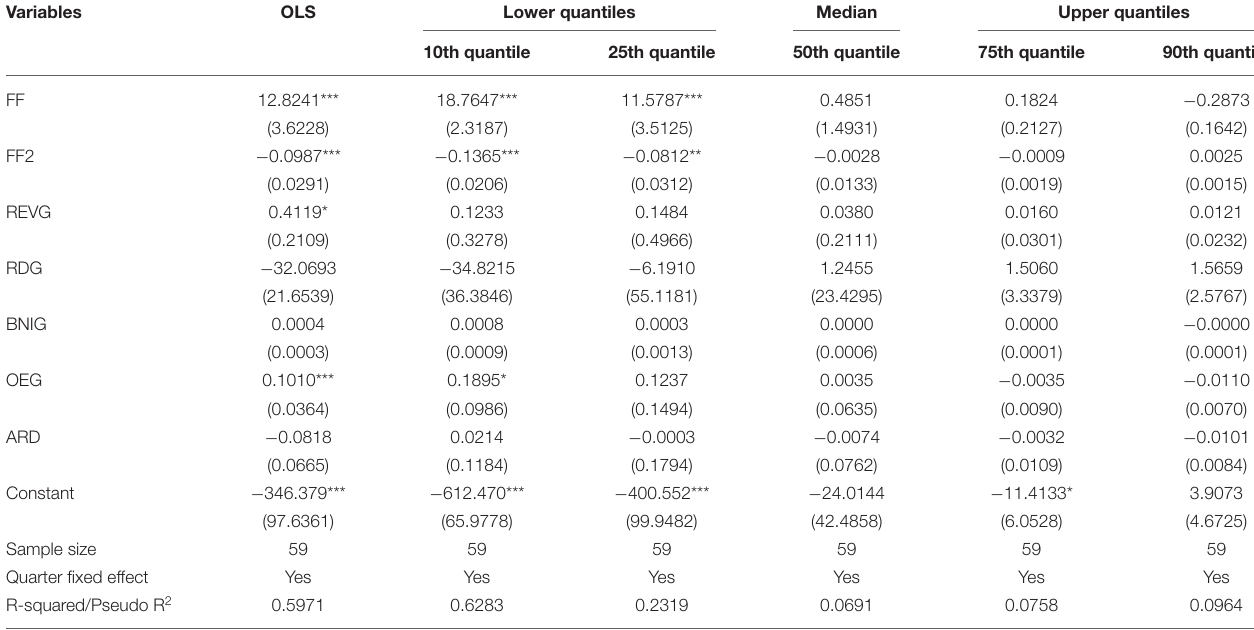
TABLE 9 | Robustness test results of SIZE: small